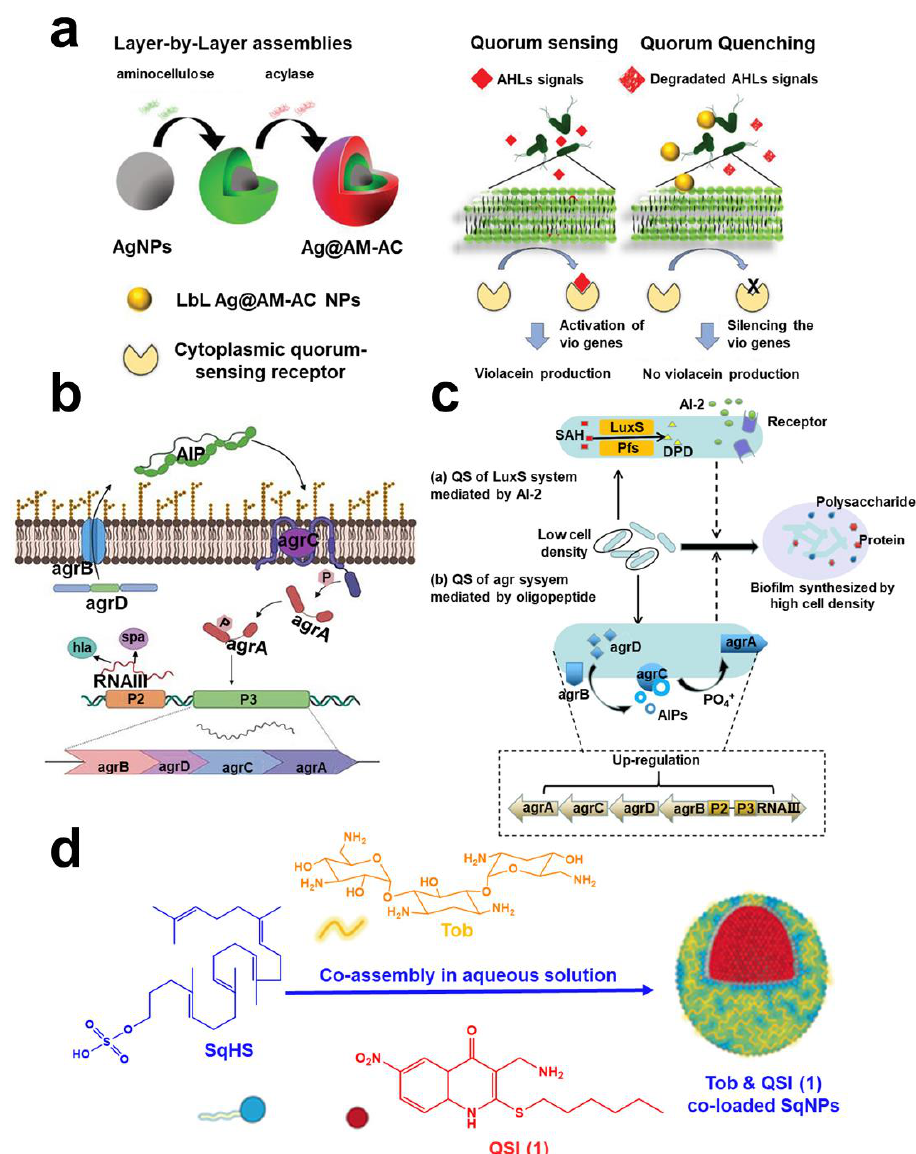
Figure 5. Quorum sensing targeting technology . ( a ) A schematic diagram of QQE acylase and amino-bearing biopolymer AM was covered layer by layer on the AgNPs template. Reprinted from Ref. [111]. ( b ) Schematic diagram of the agr QS system and expression of QS-related genes in